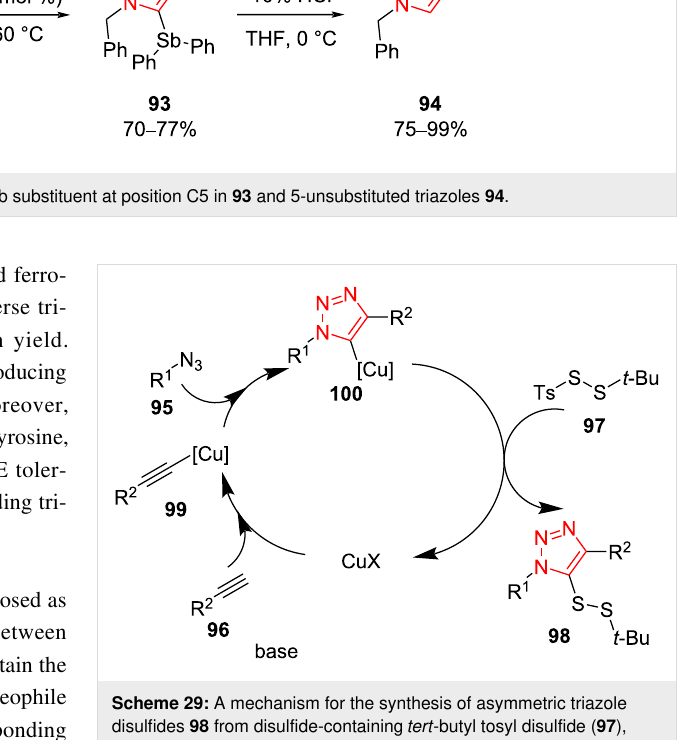
alkynes 96 , and azides 95